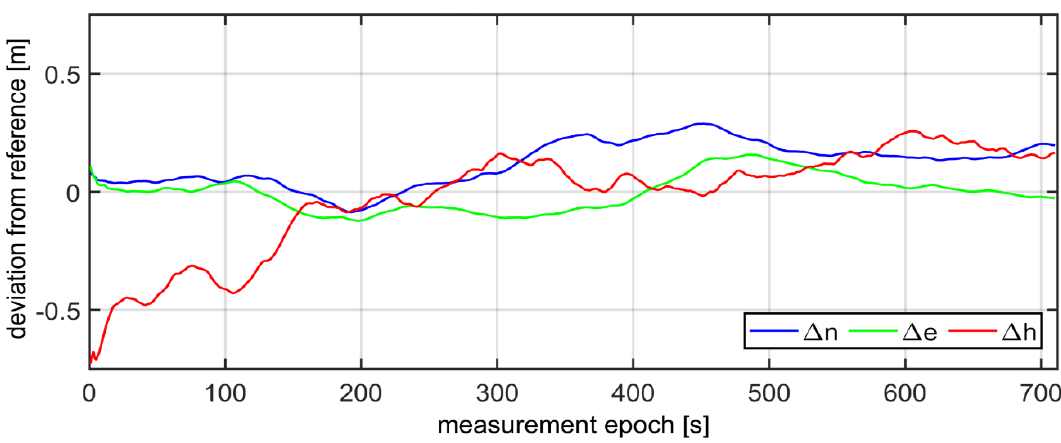
Figure 7. True errors of final GPS-EGNOS positioning by means of three GPS receivers and Kalman filter.